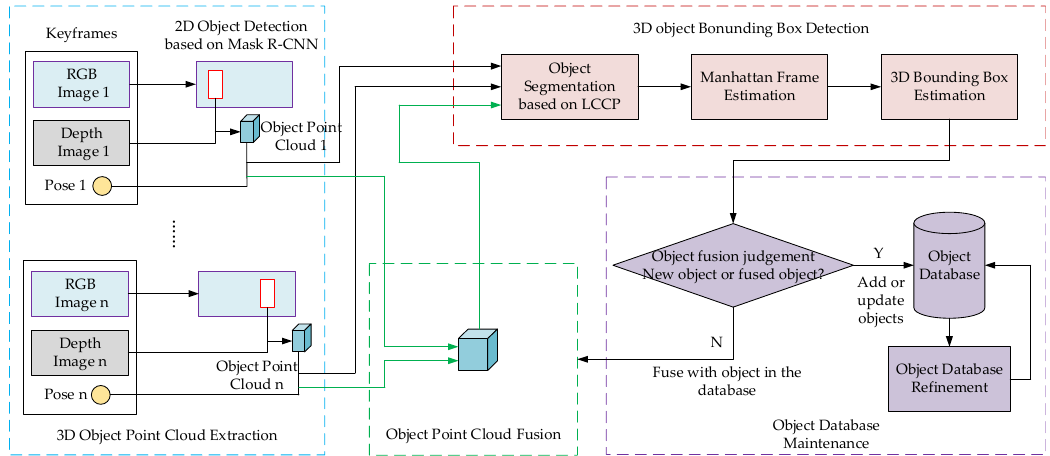
Figure 2. Schematic diagram of the 3D object detection algorithm based on multiple keyframes fusion observation.